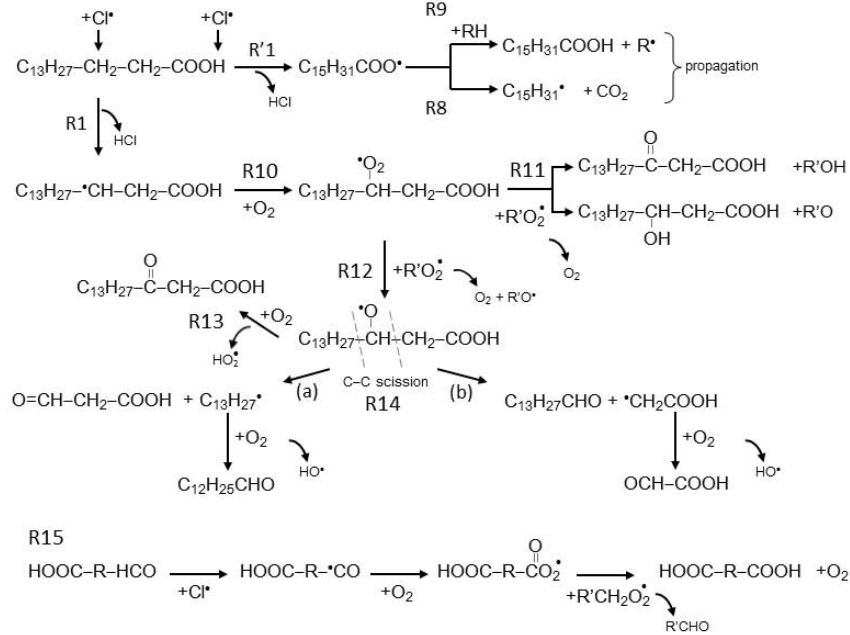
Fig. 8. Reaction mechanism for the chlorine-radical-initiated oxidation of palmitic acid in the presence of O 2 .